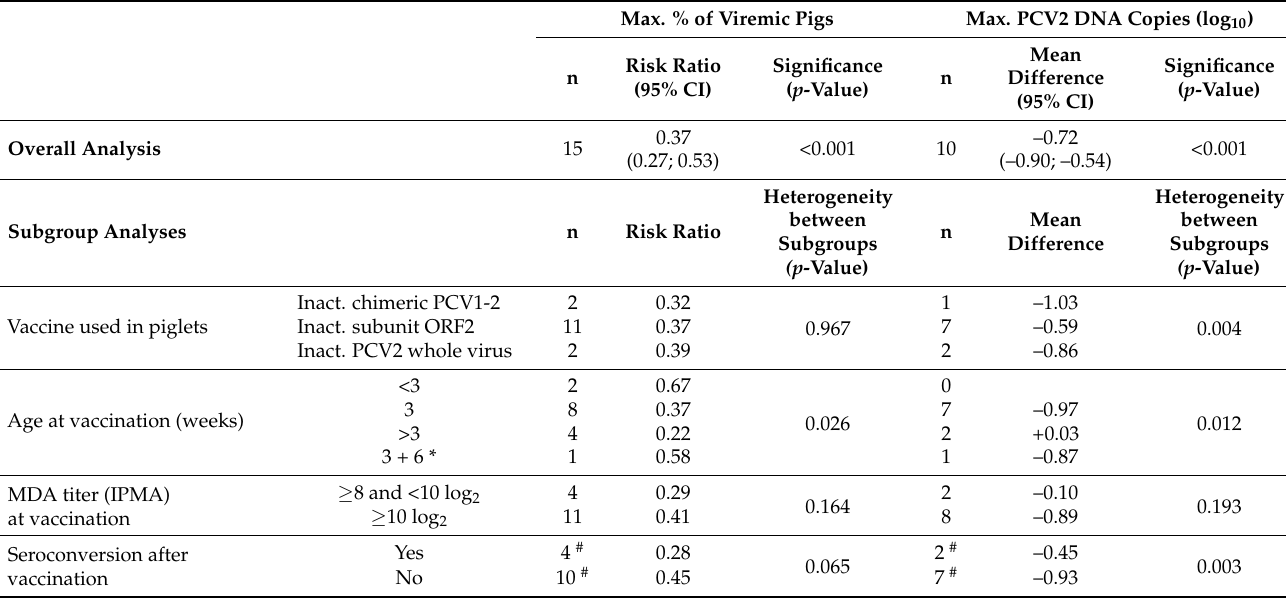
Table 4. Differences in virological parameters (maximum percentage of viremic pigs and maximum PCV2 DNA copies in serum at any time during the study observation period) between vaccinated and unvaccinated pigs with high levels of MDA at the age of vaccination against PCV2.